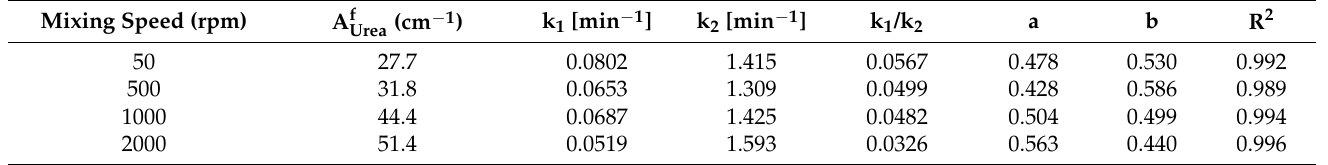
Table 7. Effect of mixing speed on urethane formation: results of the fitting procedure.